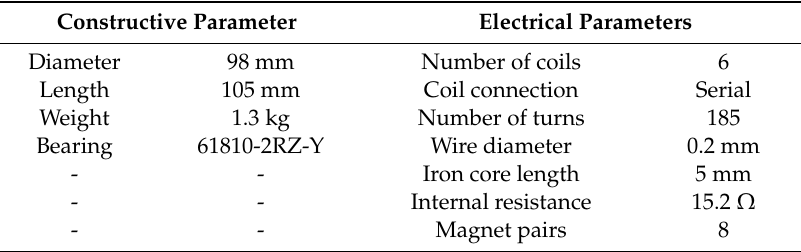
Table 2. Constructive and electrical parameters.